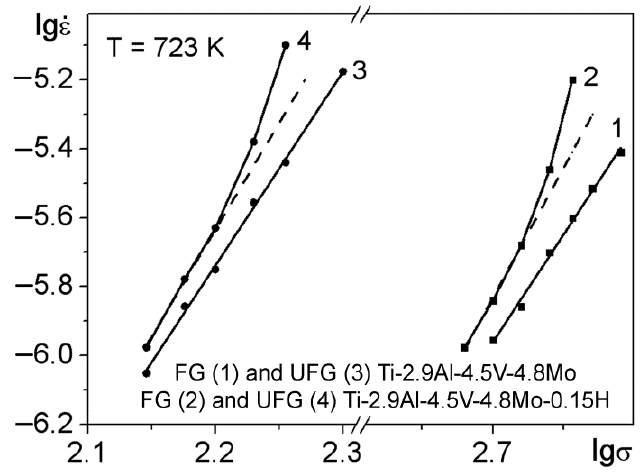
Figure 7. Experimental dependences of the steady creep rate on the stress of the FG and UFG tita- alloys. nium alloys.